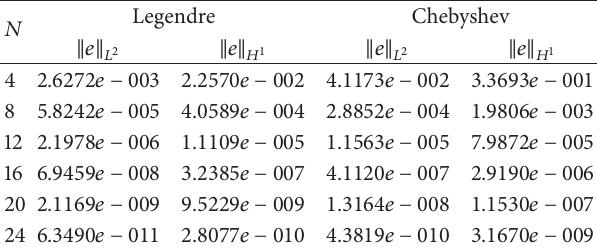
Table 6: Error discretization for 𝐶 = 0.1 and 𝑏 = 10 for Example 3.